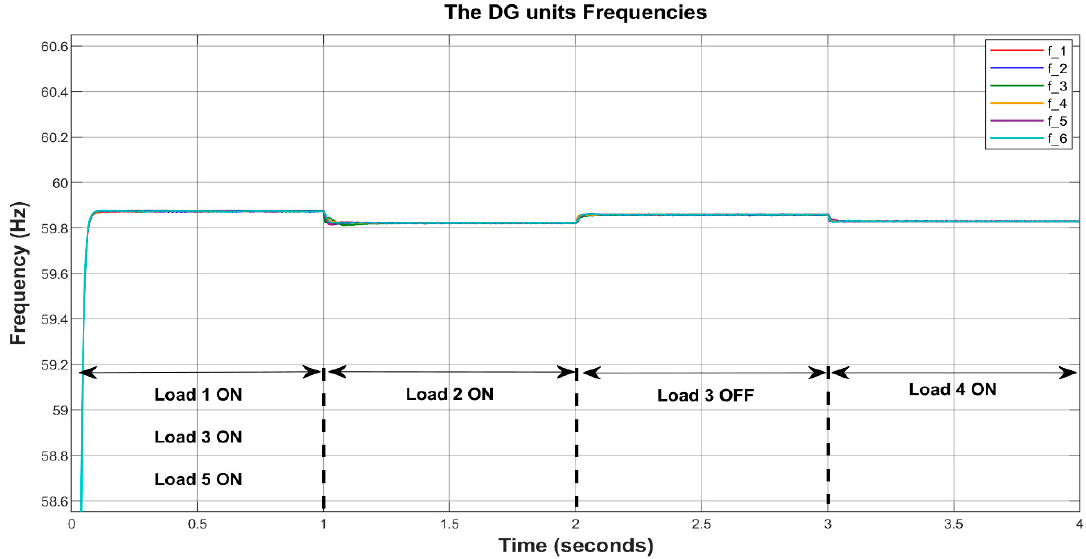
Figure 13. The DG units’ frequencies for Case 2.